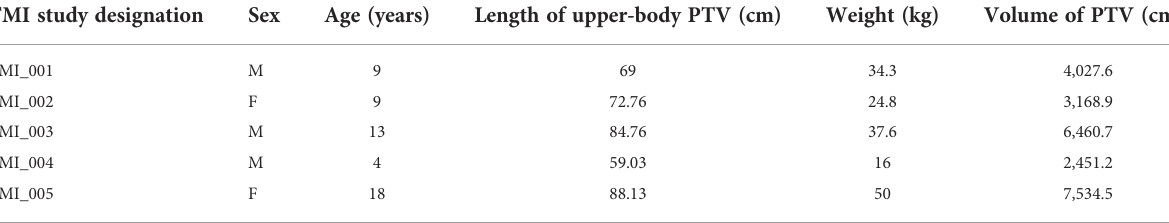
TABLE 1 Patient demographics used for treatment